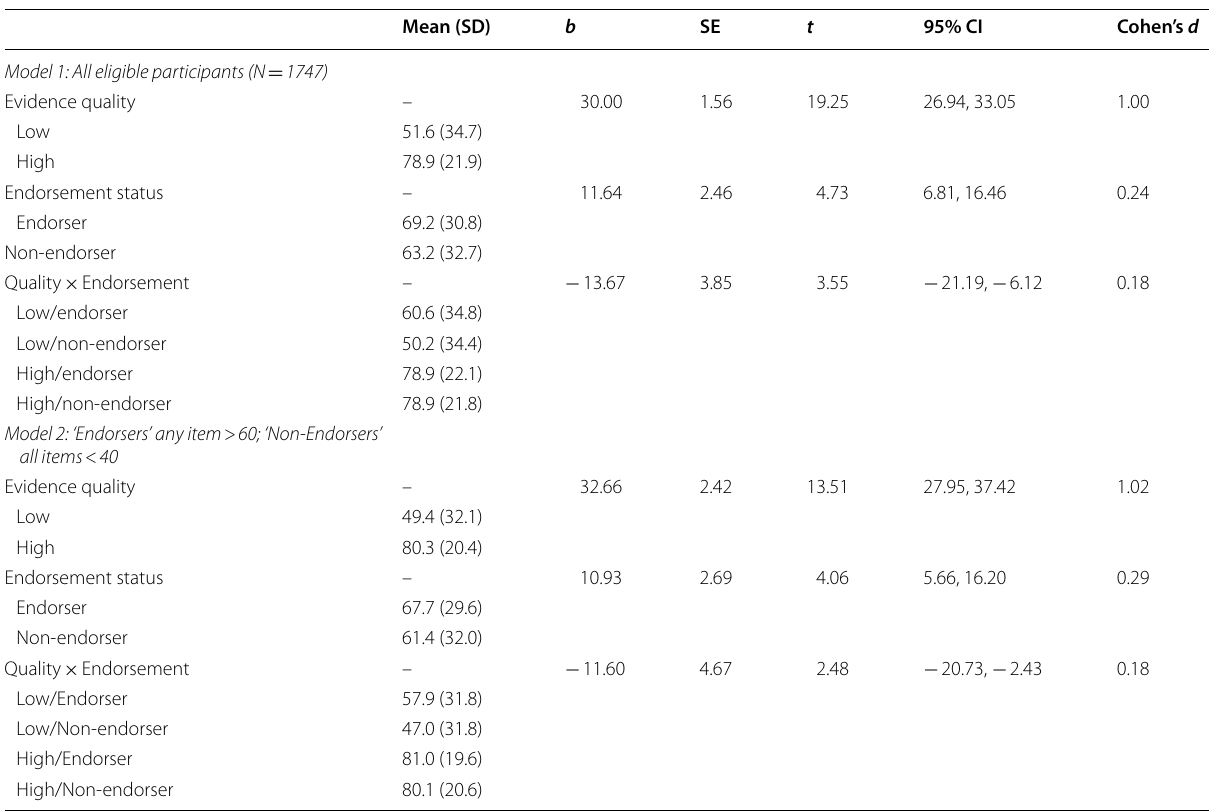
Table 3 Post hoc linear mixed-effects models 1 and 2 predicting credibility, value and weight from evidence quality, endorsement status, and the quality by endorsement